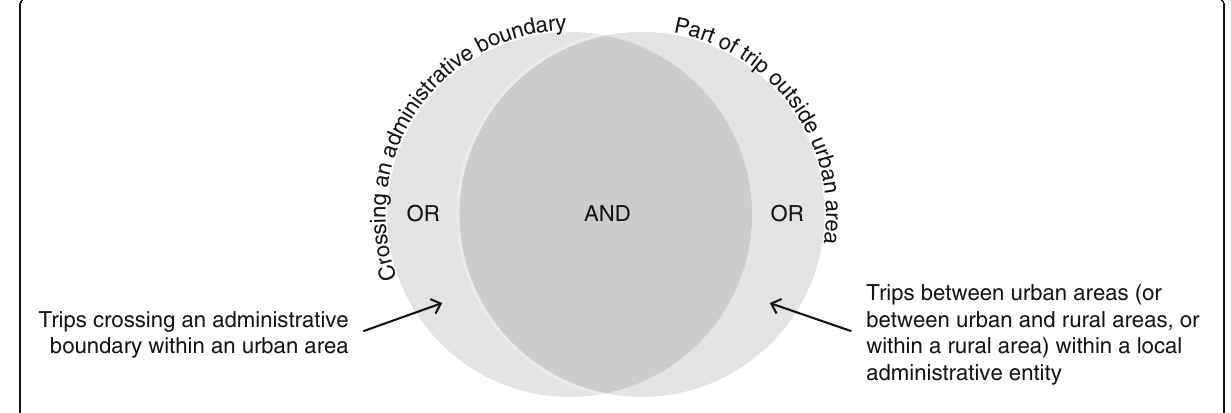
Fig. 2 Venn diagram for the inner boundary of regional